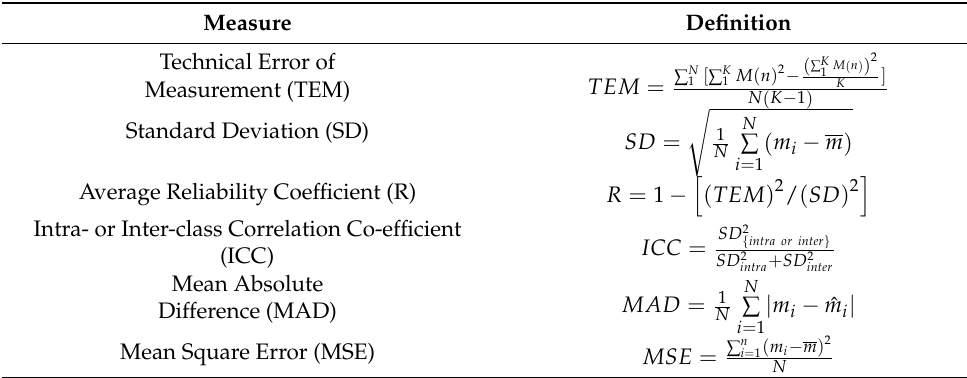
Table 1. Statistical measures for variability of the